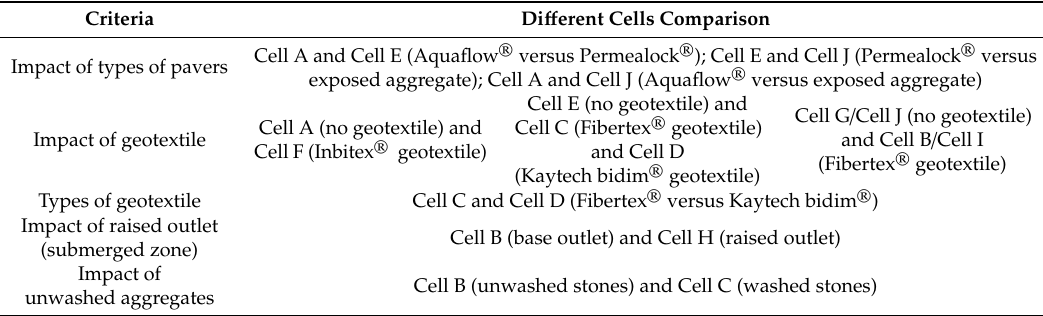
Table 2. Determination of the impact of different criteria.